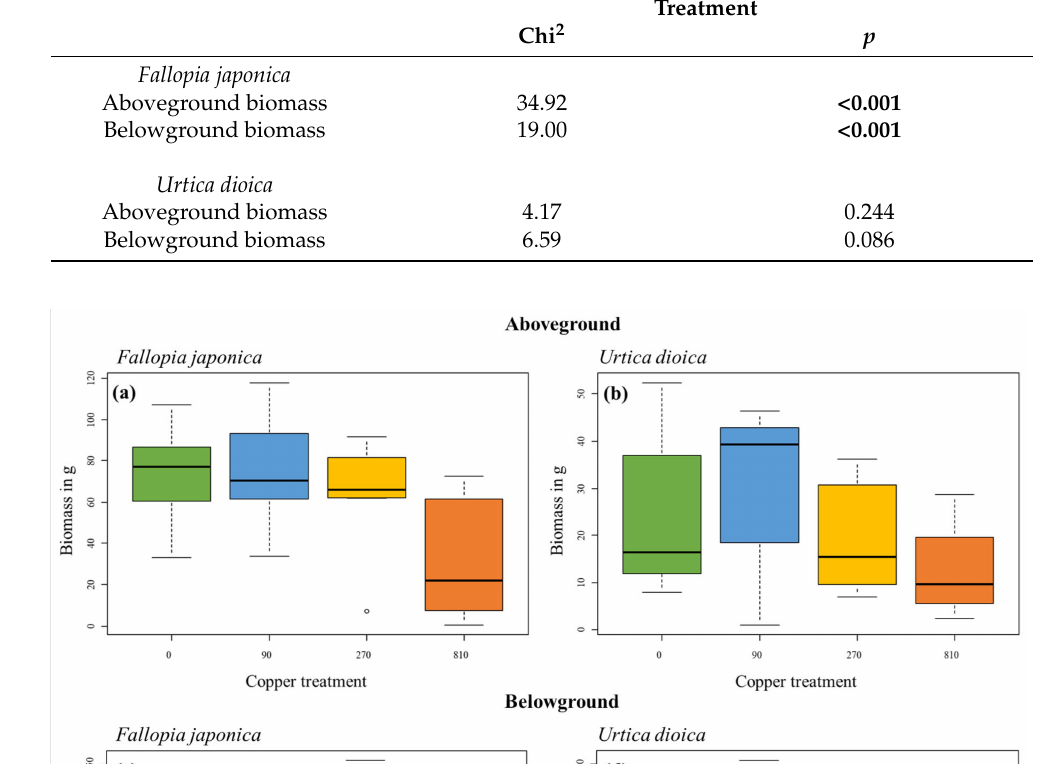
Table 2. Results of the lmer models for both Fallopia japonica and Urtica dioica above- and belowground plant biomass collected at the end of the second growing season. Chi-squared and corresponding p -value for each analyzed parameter are given. Treatment represents the effect of the copper treatment. Significant values below the level of 0.05 are printed in bold.